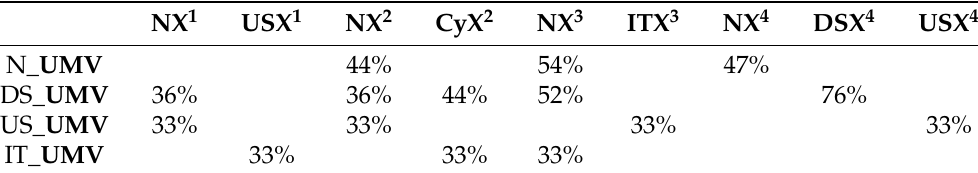
Table 4. Conditional Probability Table summary related to the pattern contribution.